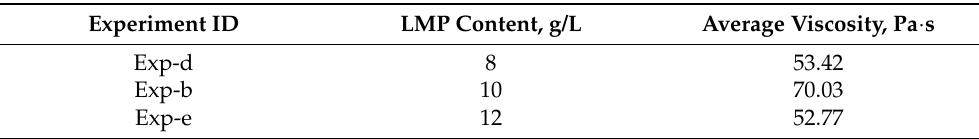
Figure 11. Colloid viscosity with increasing temperature at different contents of LMP. Table 5. Average values of viscosity for Exp-d, Exp-b, and Exp-e.